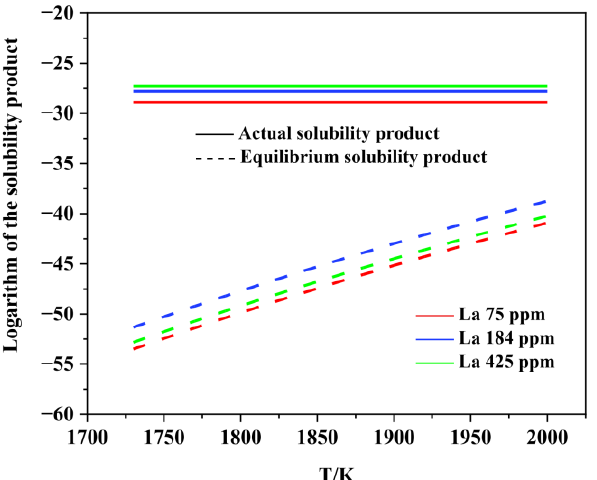
Figure 10. Logarithm of the solubility product as a function of temperature for La 2 O 2 S in liquid steel.